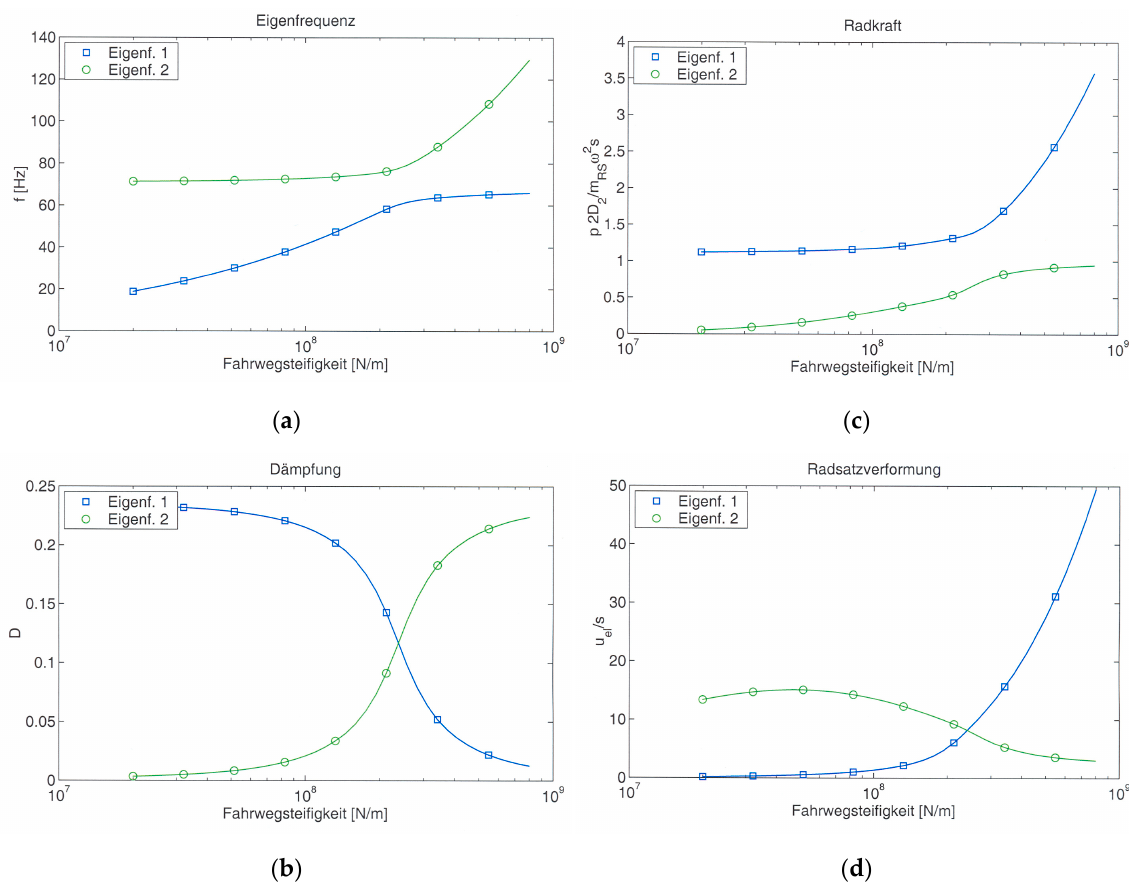
Figure 1. ( a ) Measurement points of the railway vehicle (passenger car) for the test runs, axle boxes A1, A2, bogie B1 and B2, carriage C1 and C2, right hand side, A3, A4, B3, B4, C3, C4 symmetrically on the left hand side; ( b ) one-third octave band spectra of the accelerations of the railway vehicle running with v T = 160 km/h, , wheelset A1 and A2, , vertical bogie part B1 and B2,